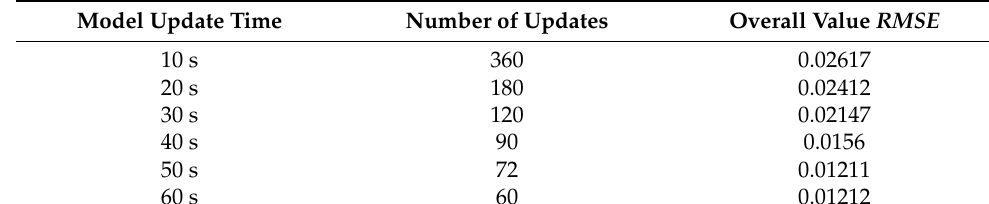
Table 2. The overall value of the RMSE of the model under different update cycles.